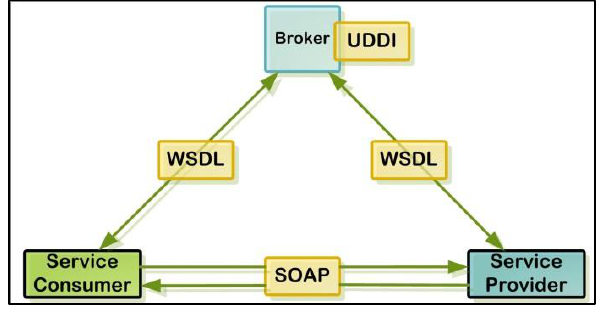
Fig. 13. Fundamental elements of a web-service.